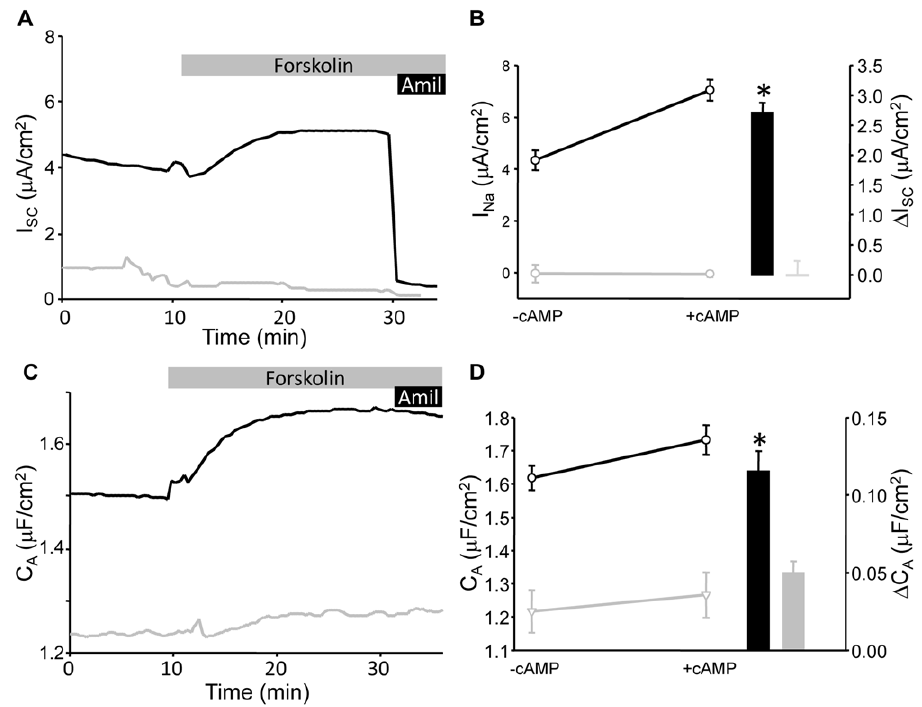
Figure 5. ENaC expression in FRT cells . (A) Representative I SC trace from FTR epithelial cells transfected with a , b , c ENaC (black trace) or control plasmid (grey trace), mounted in Ussing chambers and stimulated with 10 m M forskolin (grey bar). The expression of ENaC was confirmed by the addition of 10 m M amiloride (black bar) at the end of the recording. (B) Data from a number of similar experiments (n=34) are summarized. Basal (-cAMP) and forskolin-stimulated ( + cAMP) I Na are presented on the left and the change in I SC with foskolin stimulation ( D I SC ) on the right (bar graph). (C) Representative capacitance trace from the same samples provided in (A). (D) Summarized data for capacitance changes under basal and forskolin- stimulated conditions as in (B). (* - indicates significantly different from untransfected p ,